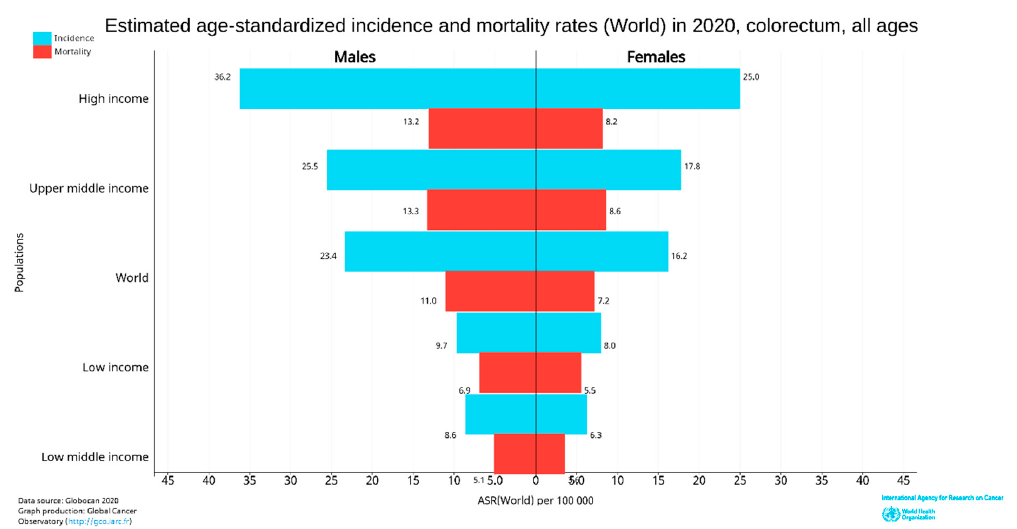
Figure 4. World CRC incidence and mortality rates in 2020 (according to income level for all age groups). The data were extracted from GLOBOCAN [25] with permission.